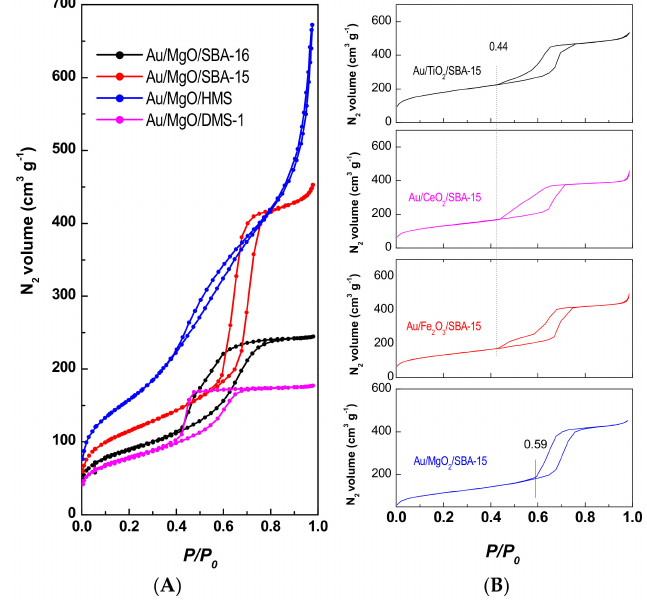
Figure 3. N 2 adsorption-desorption isotherms at − 196 ◦ C of the as-prepared Au/MgO/MSM ( A ) and Au/MO x /SBA-15 ( B )